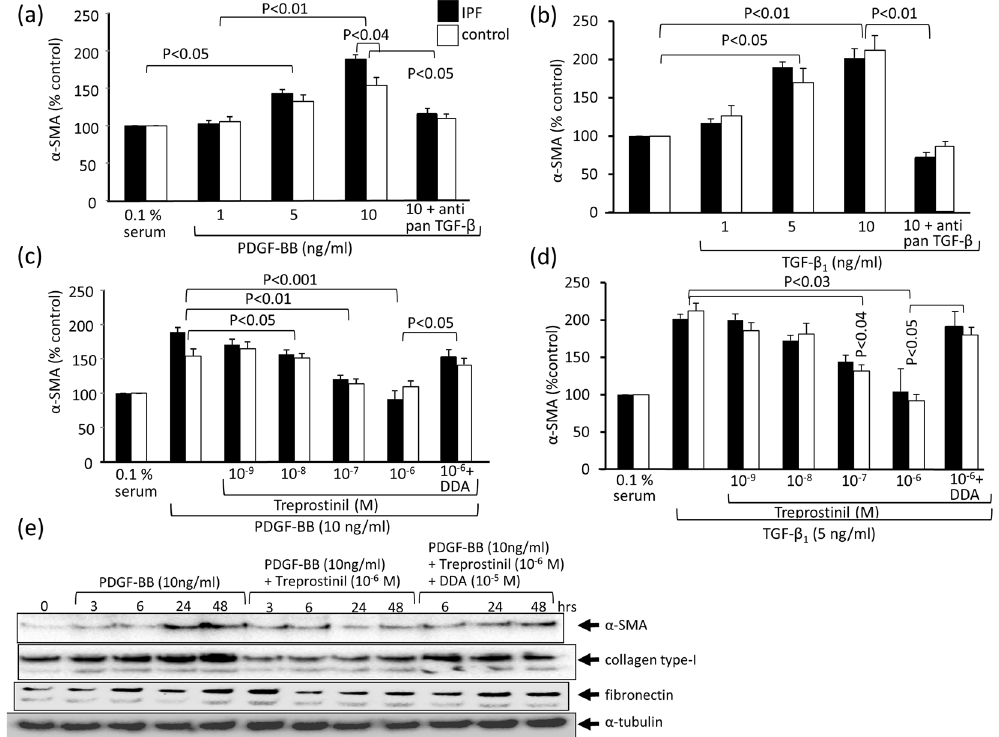
Figure 2. The effect of Treprostinil on PDGF-BB and TGF- β 1 induced α -SMA expression. ( a ) Dose dependent stimulation of α -SMA expression by PDGF-BB in fibroblasts over 24 hrs as measured by immuno-blotting and densitometric analysis. Anti-pan TGF- β antibody (1 μ g/ml) was added together with PDGF-BB. ( b ) Dose dependent stimulation of α -SMA expression by TGF- β 1 in fibroblasts over 24 hrs as measured by immuno- blotting and densitometric analysis. Anti-panTGF- β antibody (1 μ g/ml) was added together with PDGF-BB. ( c ) Dose dependent inhibition of PDGF-BB induced α -SMA secretion by Treprostinil; DDA (10 μ M) was added 30 min before Treprostinil. ( d ) Dose dependent inhibition of TGF- β 1 induced α -SMA secretion by Treprostinil; DDA (10 μ M) was added 30 min before Treprostinil. Bars show the mean ± S.E.M. triplicates in all primary control and IPF cell lines. Statistics: Mann-Whitney U-test. ( e ) Representative immuno-blots for the effect of PDGF-BB (10 ng/ml), Treprostinil (10 − 6 M) and DDA (10 − 5 M) on the expression of α -SMA, collagen type-I and fibronectin ( α -tubulin served as house keeping protein) after 42 hrs. Similar results were obtained in all other cell